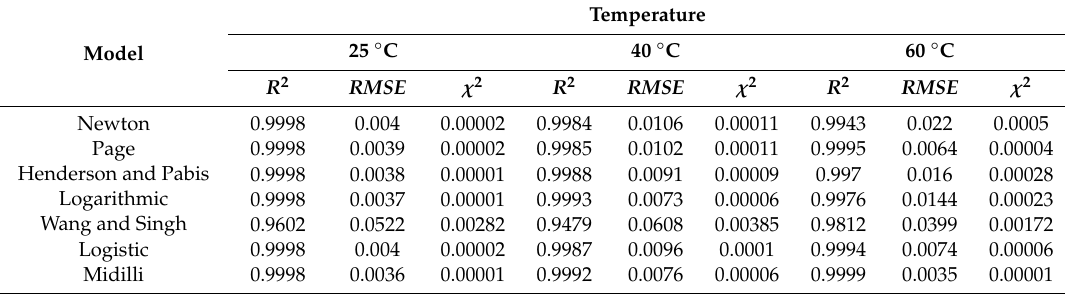
Table 3. Analysis of models describing the kinetics of air drying of wild strawberry fruits.